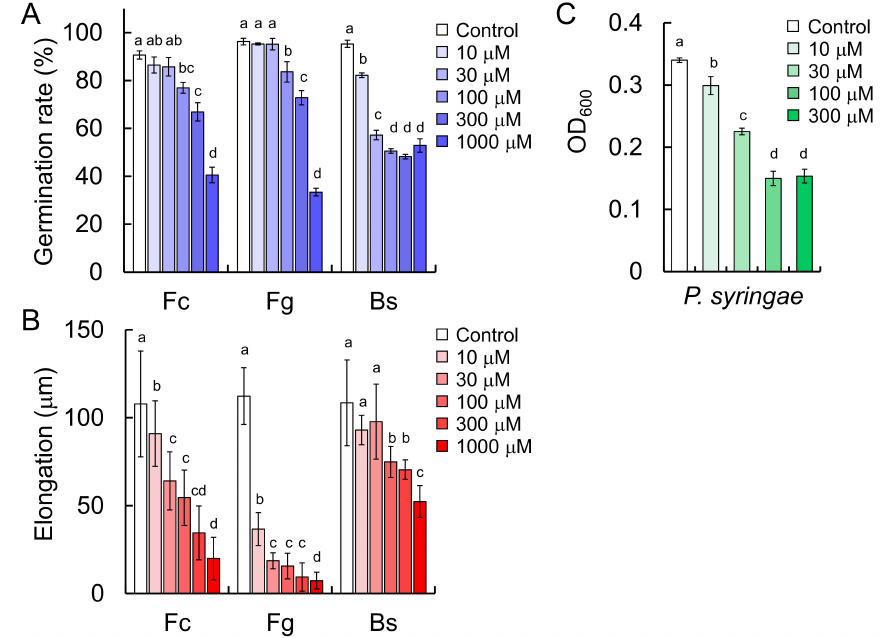
Figure 8. Antimicrobial activities of triticamide C. ( A ) E ff ect of triticamide C on the germination of Fusarium culmorum (Fc), Fusarium graminearum (Fg), and Bipolaris sorokiniana (Bs) conidia. Germination rates were measured at 6 h (for Fc and Fg) and 8 h (for Bs) after inoculation. ( B ) E ff ect of triticamide C on conidial germ tube elongation, which was measured 4 h after treatment with triticamide C. ( C ) E ff ect of triticamide C on the growth of Pseudomonas syringae pv. japonica. Growth was assessed by measuring OD 600 at 0 and 24 h after the start of incubation. Values and error bars represent mean ± SD ( n = 3). Letters (a–d) represent significant di ff erences at p < 0.05 as measured using Tukey-Kramer